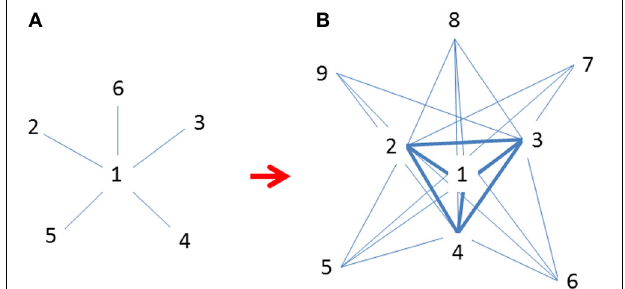
FIGURE 4 | (A) Initial invasions at time t when marginal populations are only linked to central populations (Freeman’s star; Freeman, 1979); (B) Continued expansion of established populations across species’ ranges at t + 1 after initial invasion when many populations are increasingly linked to each other but mostly to central ones (revised following Borgatti and Everett, 1999). Both graphs are idealized patterns designated for approximations using observational data. Numbers indicate the emerging sequence of populations (nodes) over time; i.e., smaller numbers are older and more centrally located and